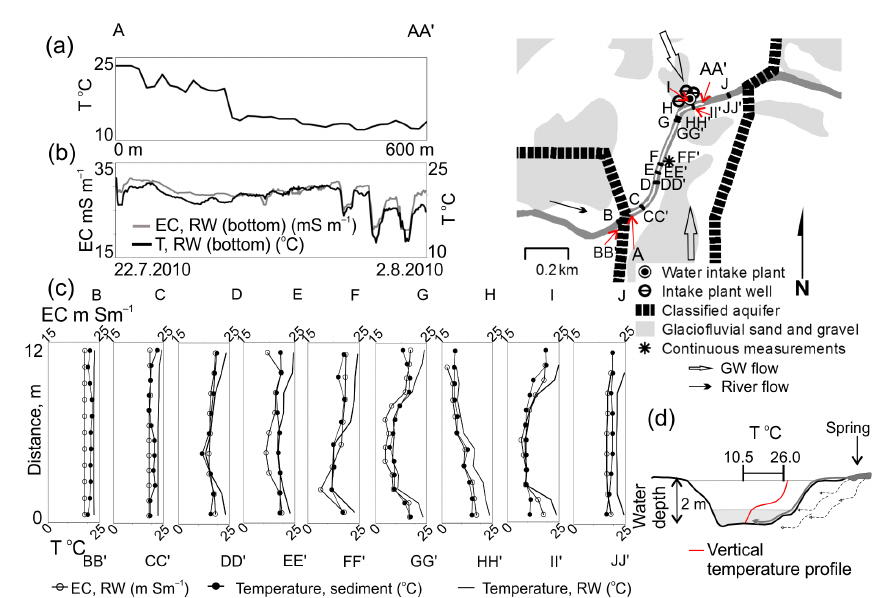
Figure 6. Field studies at the Hyvinkäänkylä study site in the low-flow period in July 2010: (a) longitudinal profile of RW temperatures (A–AA (cid:48) ) near the sediment–water interface, (b) continuous measurements of temperature and EC in RW 0.3m above the river bottom (monitoring period from 22 July to 2 August 2010), (c) cross-sectional profiles (from B − BB’ to J–JJ (cid:48) ) of temperature and EC in RW near the sediment water interface and temperature in the sediment (water depth ranging from 0.10 to 2.0m), and (d) schematic figure of stratification and the vertical RW temperature profile in the middle of the River Vantaa at cross section F–FF (cid:48) . The grey array represents the GW sinking down by the river bank and the dashed lines represent the subsurface preferential GW flow paths. (Basemap Database © National Land Survey of Finland 2010; Quaternary Deposit Database © Geological Survey of Finland 2008; Groundwater Database © SYKE 2010.)